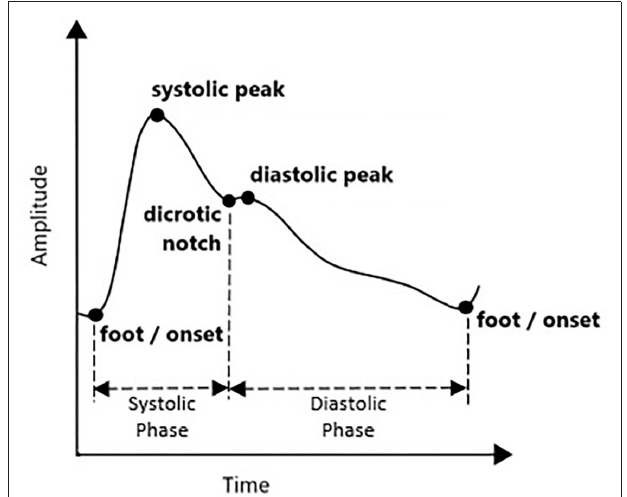
FIGURE 1 | Typical PPG waveform.